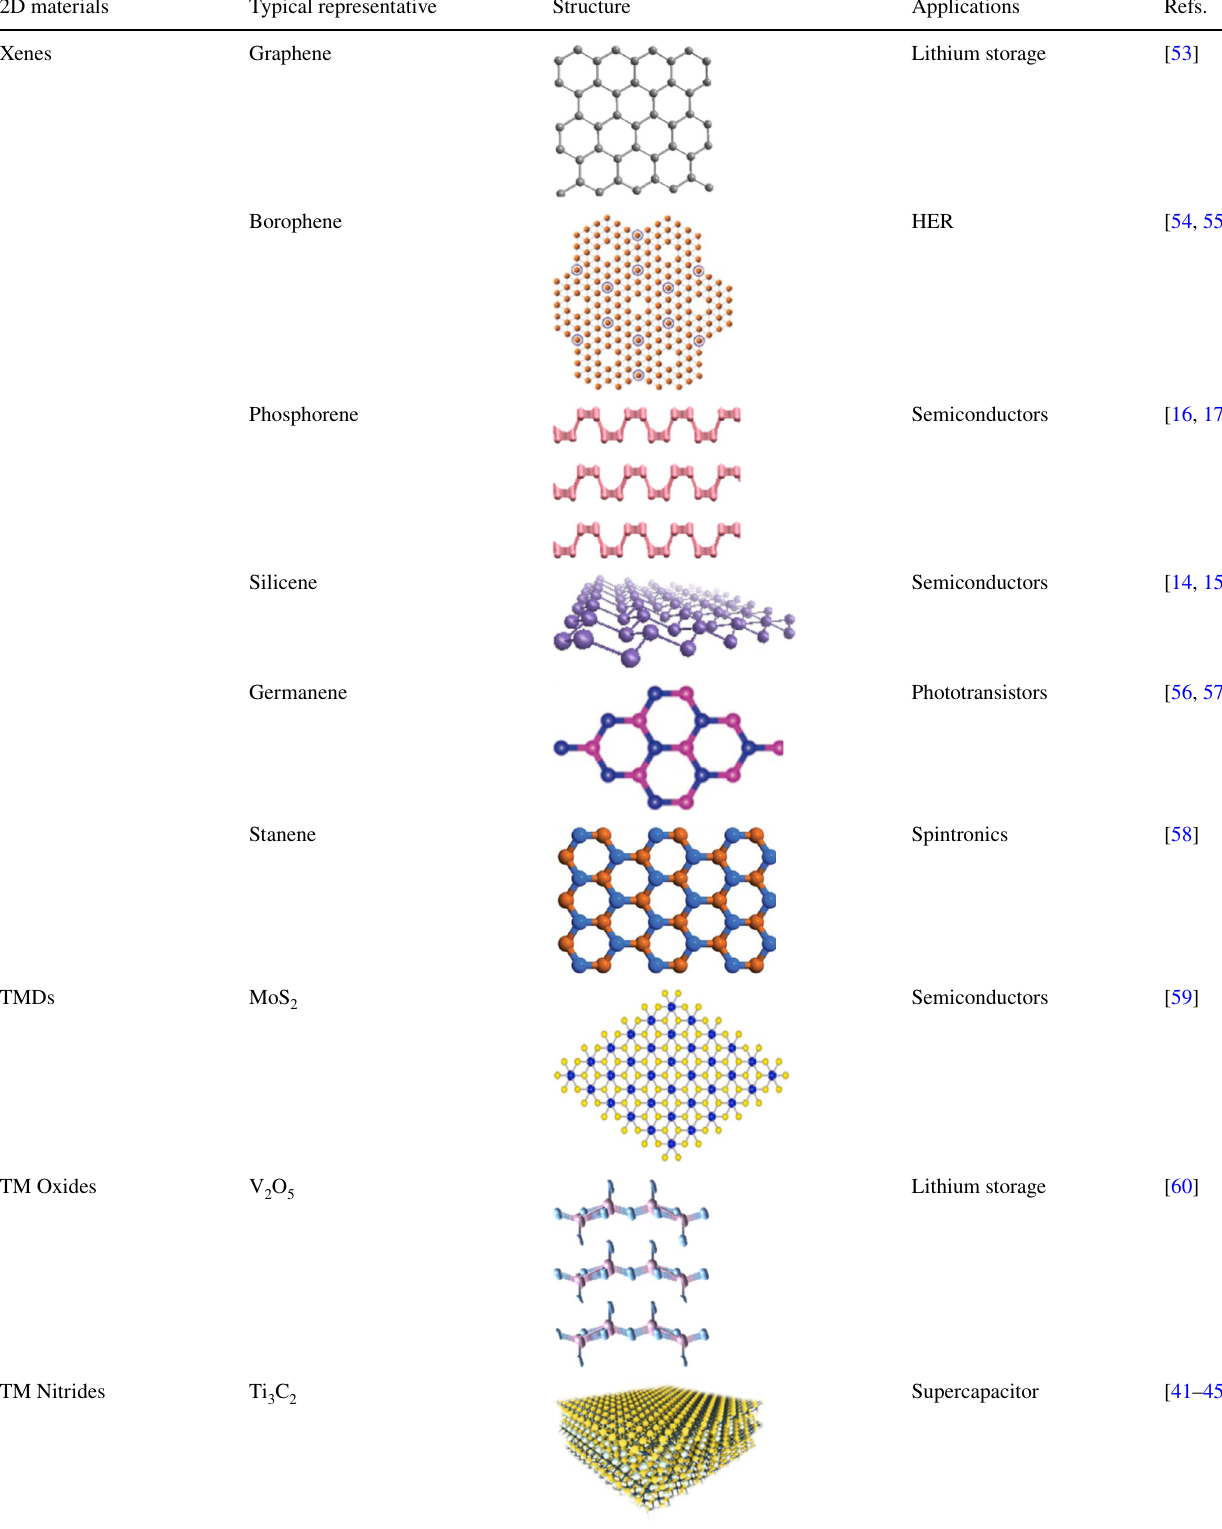
Table 1 Classification of 2D materials 2D